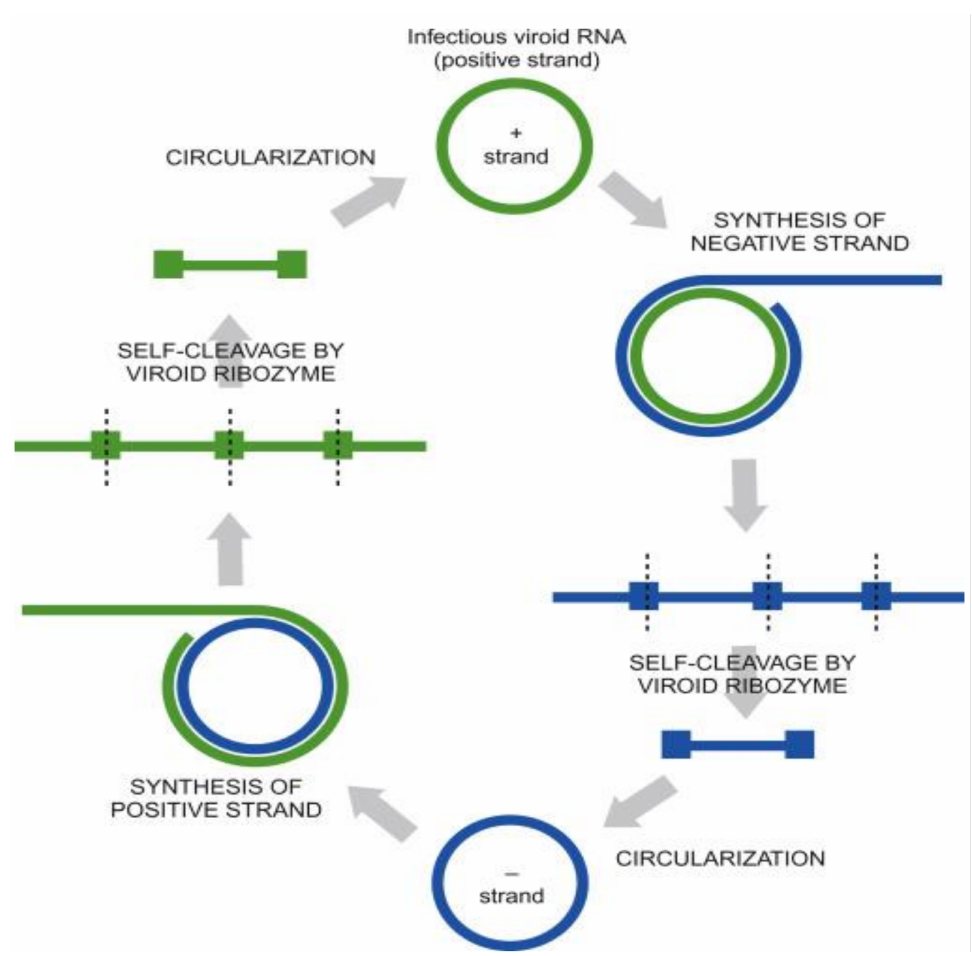
Figure 2. Rolling circle model for Avsunviroid replication (adapted from Clark et al., 2019 [69]). For PSTVd, the type member of Pospiviroidae, the absence of circular monomeric ( − ) sense RNA in plants after natural infection supports the asymmetric model of